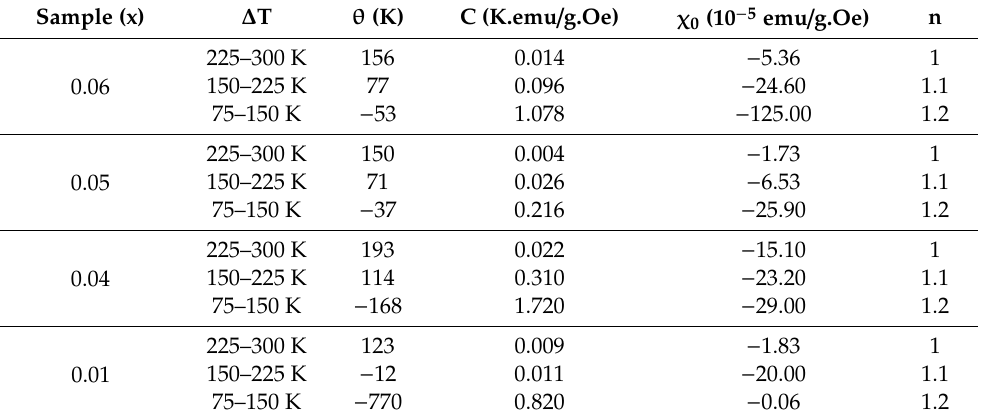
Table 2. Parameters obtained by fitting the χ − 1 (T) curves taken with H = 100 Oe for the (Zn 1-x Fe x )O